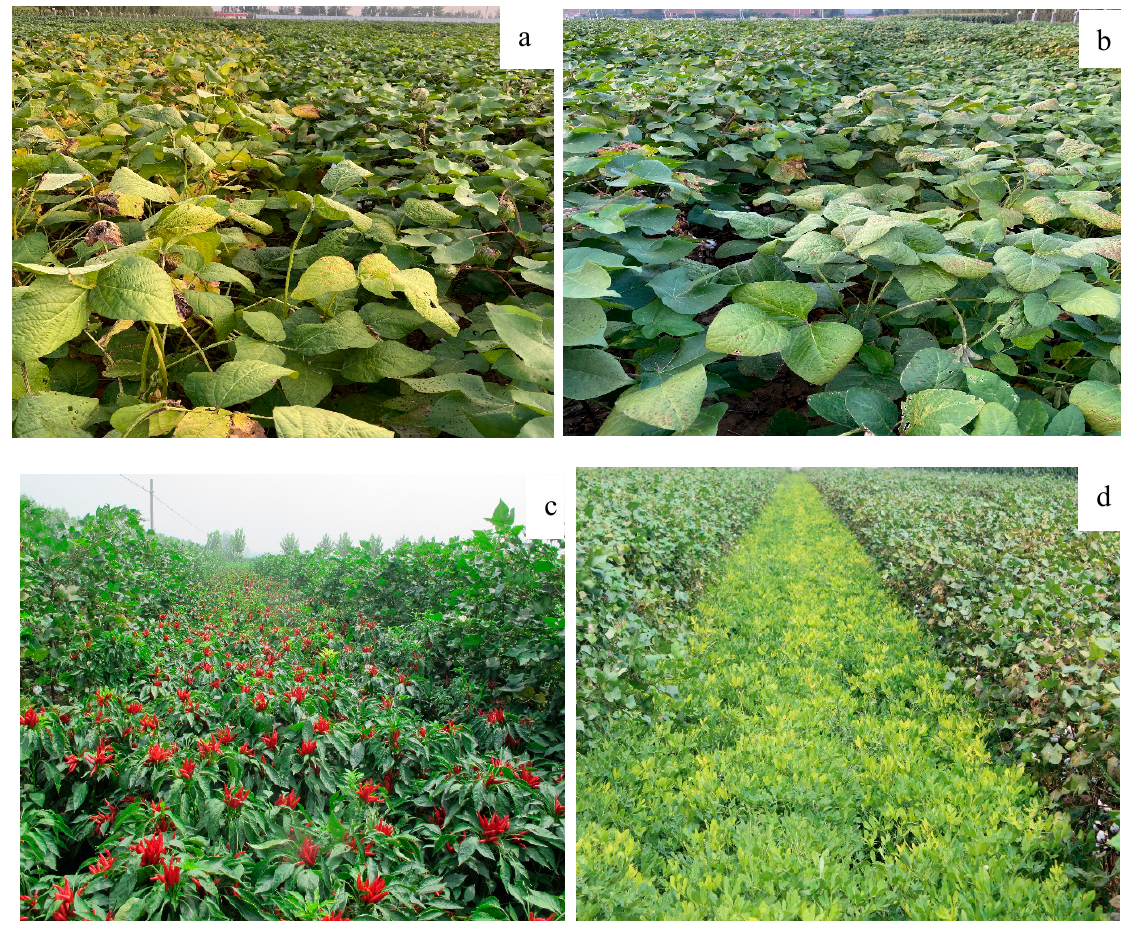
Figure 1. Traditional ( a ) and alternate ( b ) intercropping of cotton and soybean; intercropping of cotton and chili ( c ) and cotton and peanut ( d ).